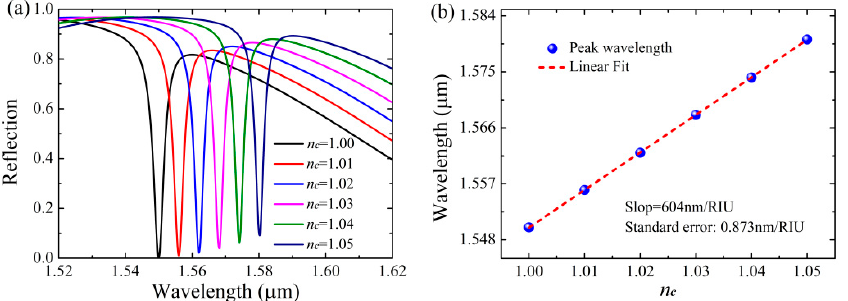
Figure 8. Sensing properties of the Si-based PCS with graphene, other parameters are the same as Figure 2 except s = 74 nm. ( a ) Reflection spectra as a function of the refractive index of the background. ( b ) Locations of the reflection dip as a function of the refractive index of the background.